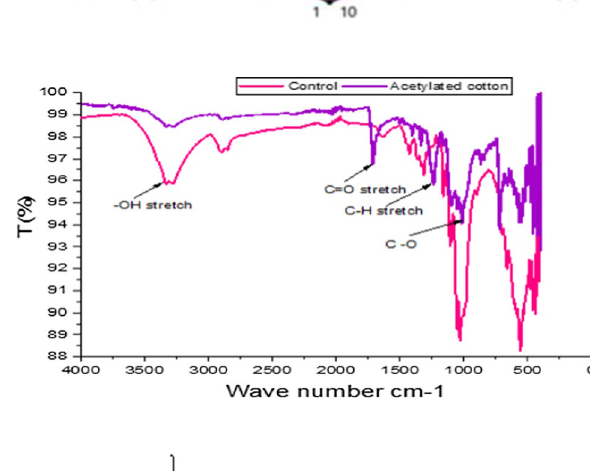
Fig. 6 Comparison of mois- ture regain and contents of control and modified PC